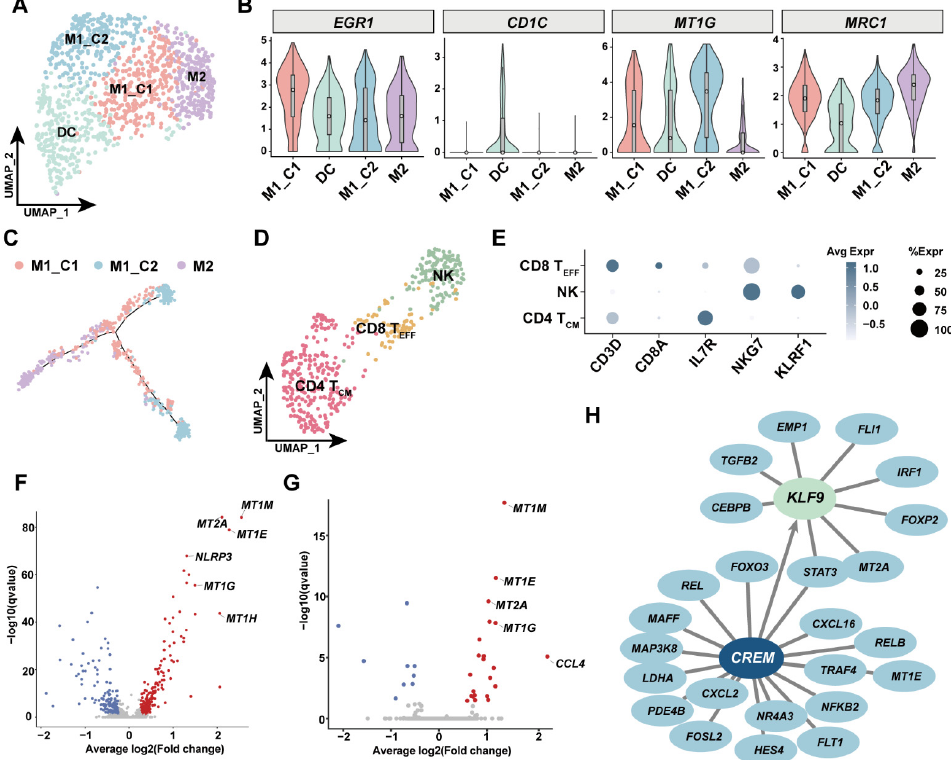
Figure 5. Single-cell analysis of major immune cells in human GSVs. ( A ) The UMAP plot of macrophages and dendritic cells in this study. DC: dendritic cells; M1_C1: proinflammatory M1 macrophage cluster 1; M1_C2: proinflammatory M1 macrophage cluster 2; M2: proreparative M2 macrophages. ( B ) Violin plot of signature genes for macrophages and DC subsets. ( C ) Trajectory analysis of three macrophage subsets. ( D ) The UMAP plot of T-cell subsets and natural killer cells. NK: natural killer cells. CD8 T EFF : effector CD8 T cells. CD4 T CM : central memory CD4 T cells. ( E ) Dot-plot of signature genes for T-cell and NK subsets. ( F ) Volcano plot showing the differentially expressed genes (DEG) in macrophages and DC between diabetic patients and nondiabetic patients. Red dots represent upregulated genes in diabetic patient (P2). ( G ) Volcano plot showing DEG in lymphocytes between P2 and P1P3. Red dots are genes upregulated in P2. ( H ) Network analysis inferred from SCENIC demonstrates that transcription factors CREM and KLF9 were involved in proinflammatory response in lymphocytes. KLF9 was one of the downstream targets of CREM